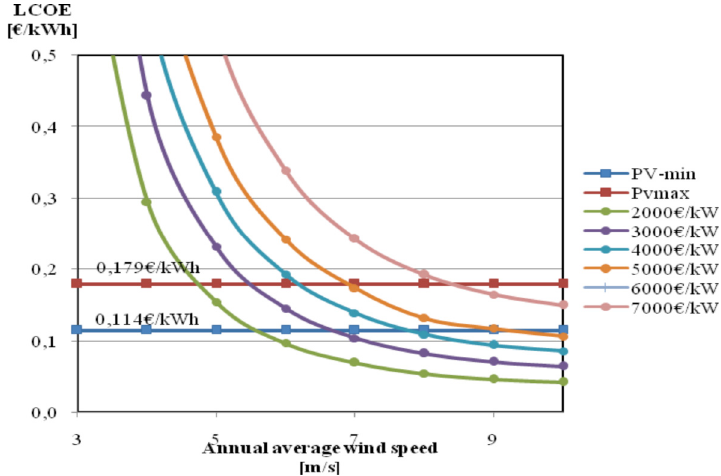
Fig. 7. LCOE for off-grid wind and